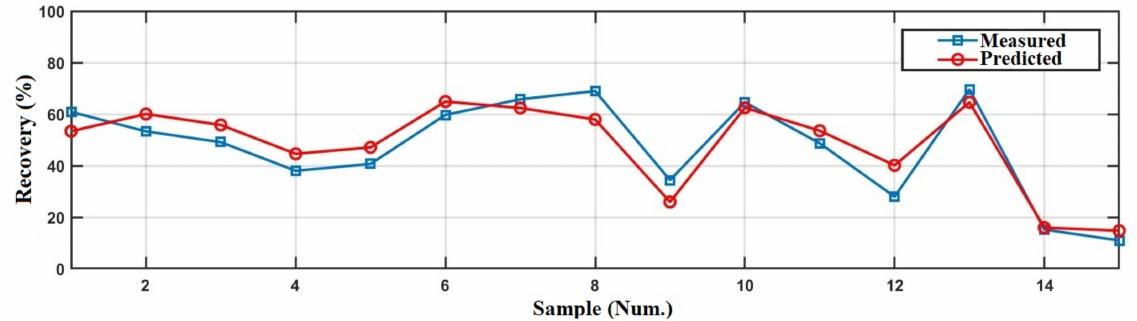
Figure 12. The comparison of measured values and predicted values for sulfur recovery using